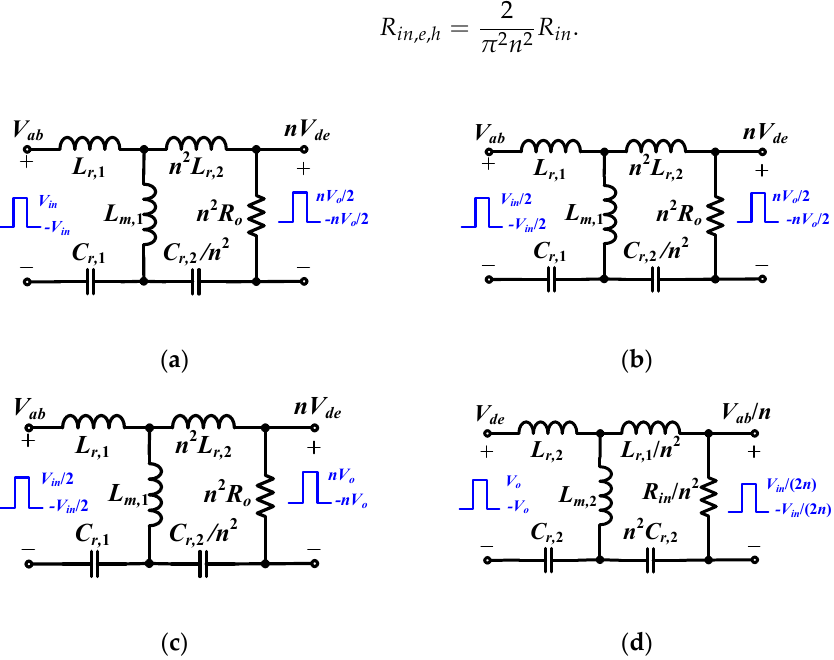
Figure 4. Equivalent resonant circuits under four operating modes: ( a ) low voltage range input with forward power flow; ( b ) medium voltage range input with forward power flow; ( c ) high voltage range input with forward power flow; ( d ) backward power flow operation.